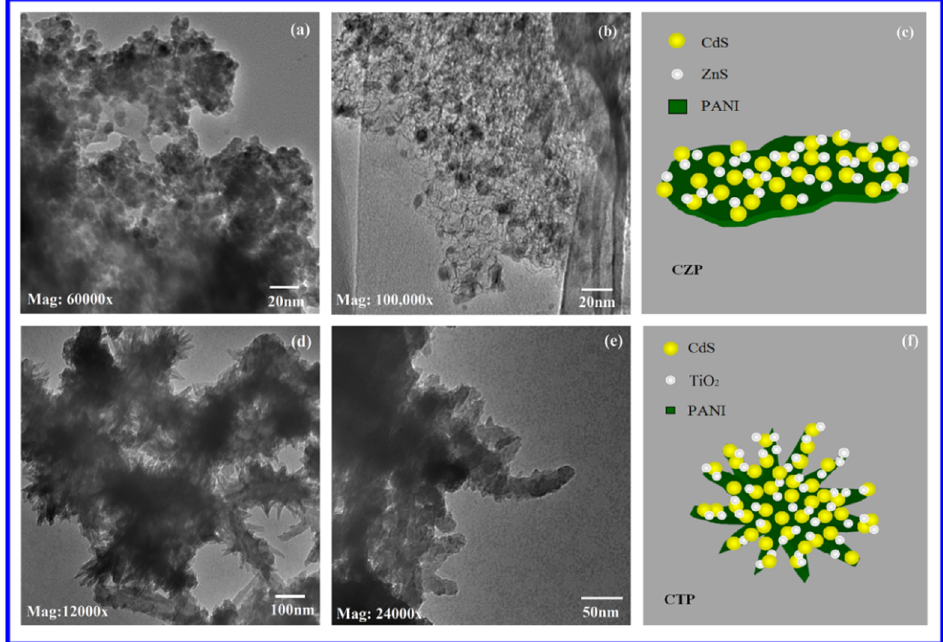
Figure 5. TEM images of ( a , b ) CZP at 60,000- and 100,000-times magnification, respectively, ( d , e ) CTP at 12,000- and 24,000-times magnification, respectively and ( c , f ) representative diagrams of CZP and CTP,